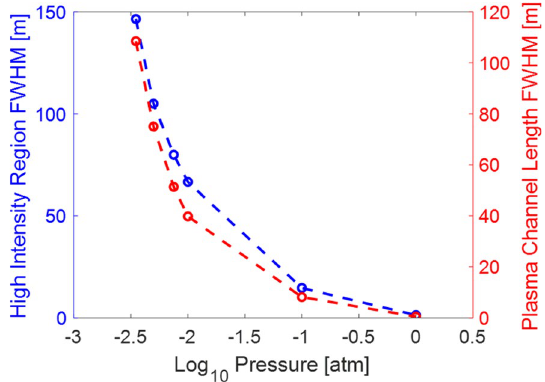
Figure 3. Simulation results comparing the filament length (i.e. region of high intensity propagation and plasma channel length) as a function of